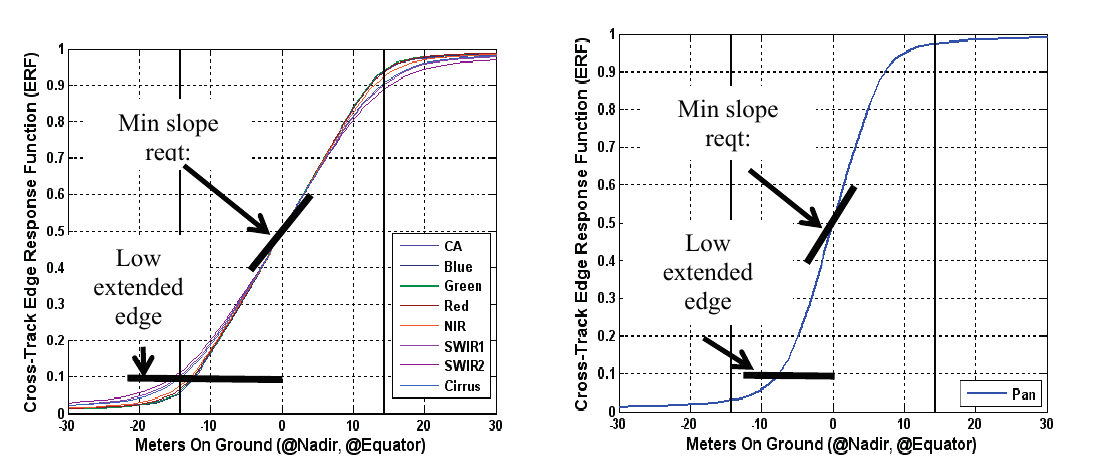
Figure 17. Spatial testing results. The edge response meets all slope, extended edge distance and sharpness requirements.